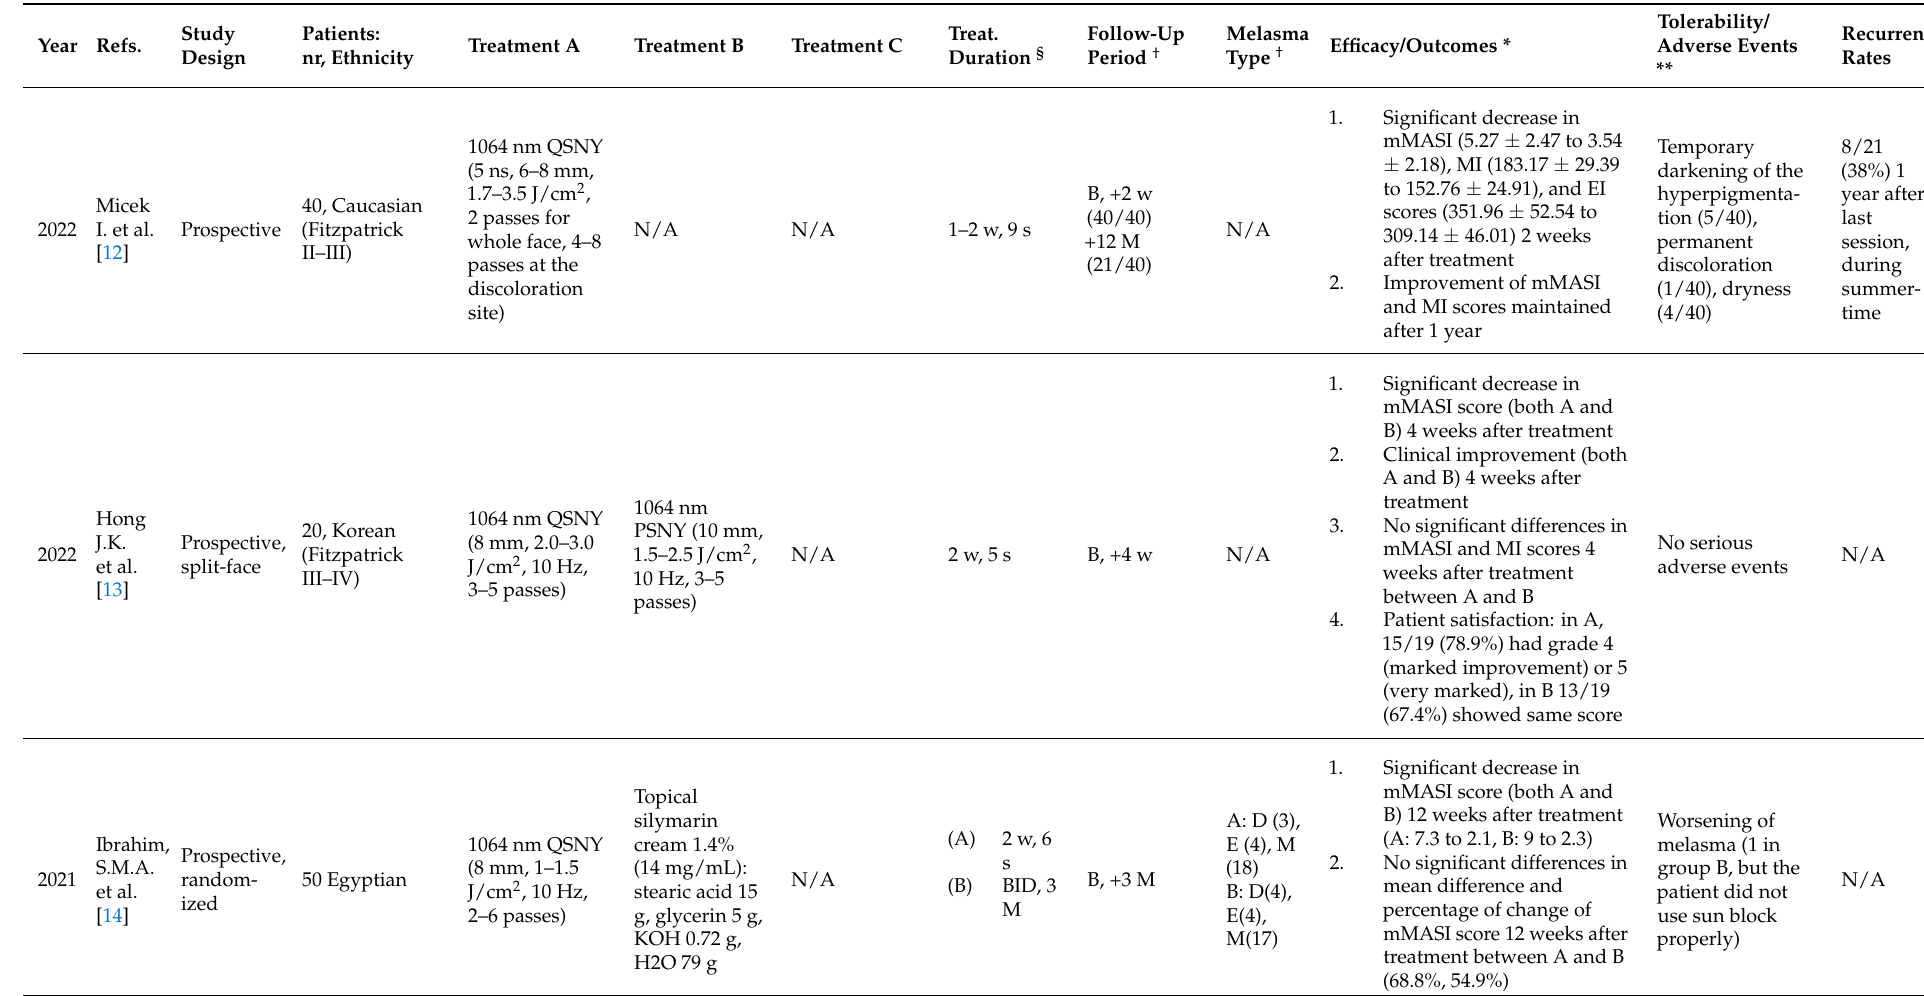
Table 1. Q-switched Nd:YAG laser with or without other treatment